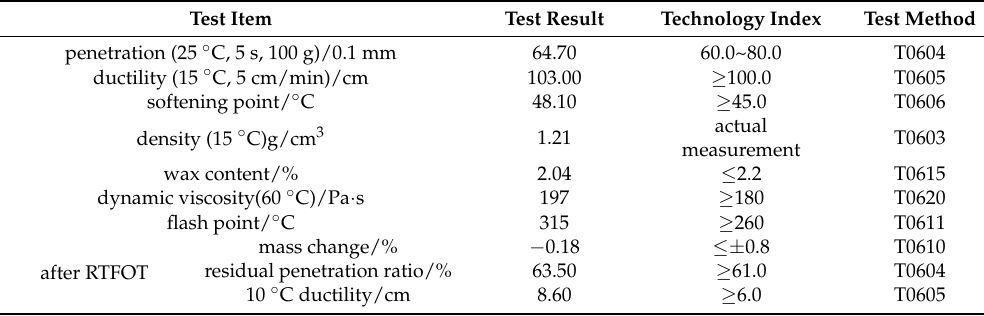
Table 1. Parameters of SK-70#